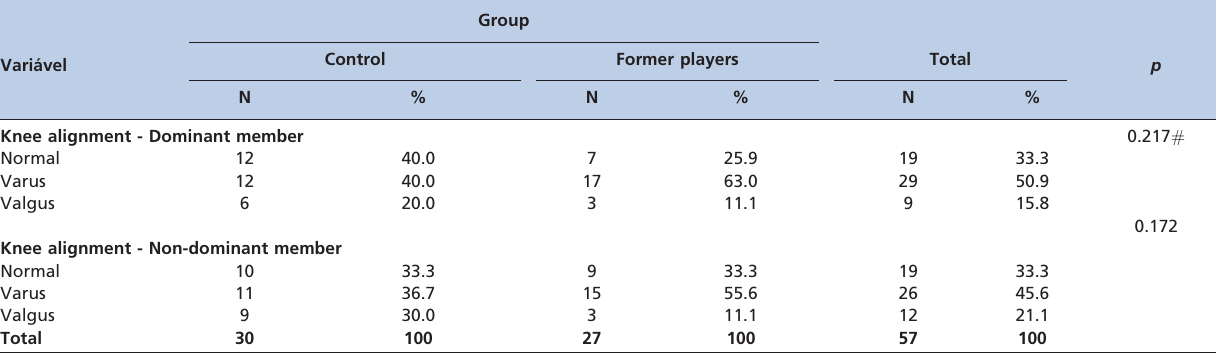
Table 2 - Knee Alignment Comparison between groups.